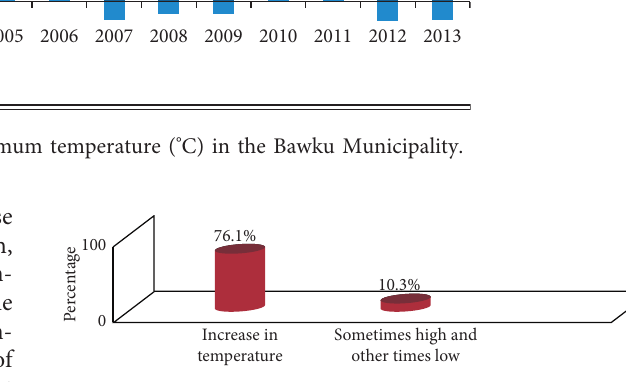
Figure 8: Respondents’ opinion on the manifestations of tem- perature